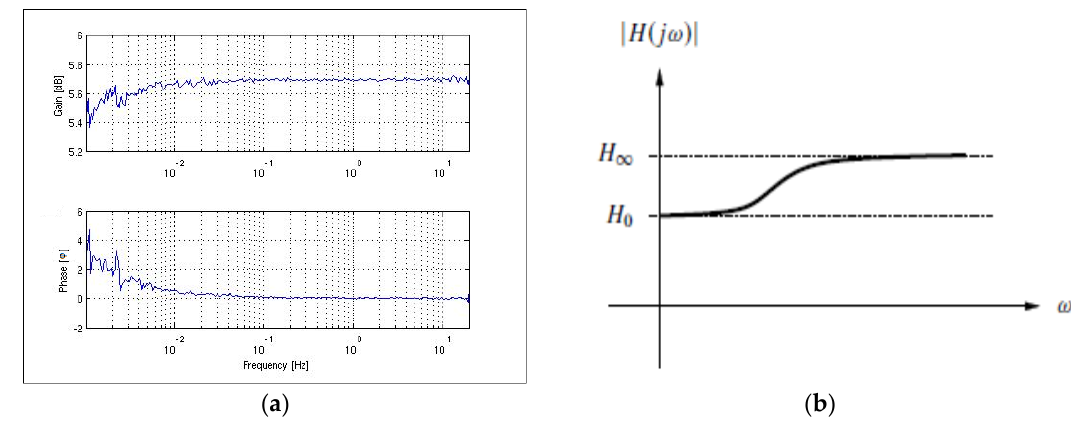
Figure 8. ( a ) Example of a measured electro-optical transfer function of LiNbO3 modulator chip with logarithmic scaling of frequency axis; ( b ) Derived model of the high-pass-type transfer function of a non-ideal phase modulator with linear scaling of the frequency